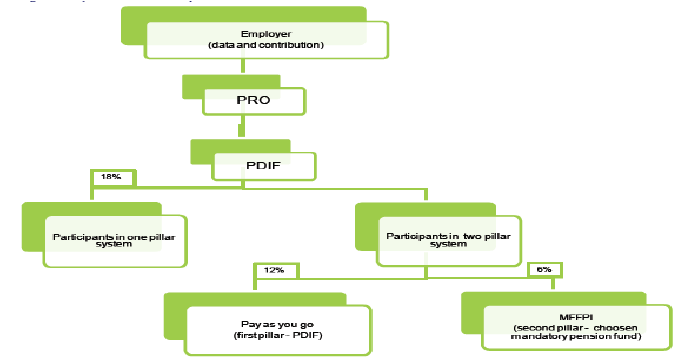
Figure 1: Distribution of mandatory pension deduction by first and second